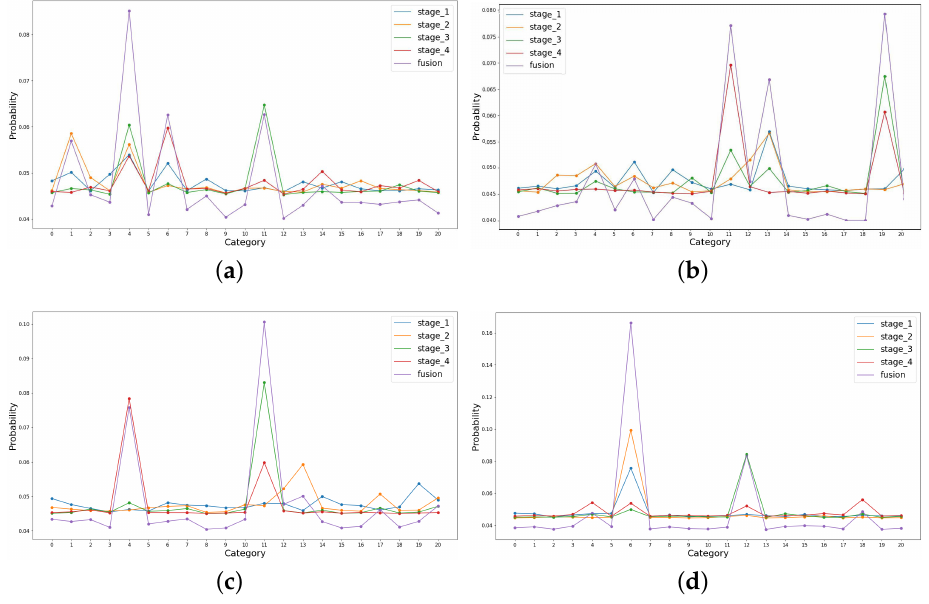
Figure 12. Visualization of the output scores in different stages. ( a – d ) illustrate the results of the images belonging to buildings, storage tanks, intersection, and dense residential respectively. All the selected images are correctly classified by the adaptive fusion method, as indicated by the purple